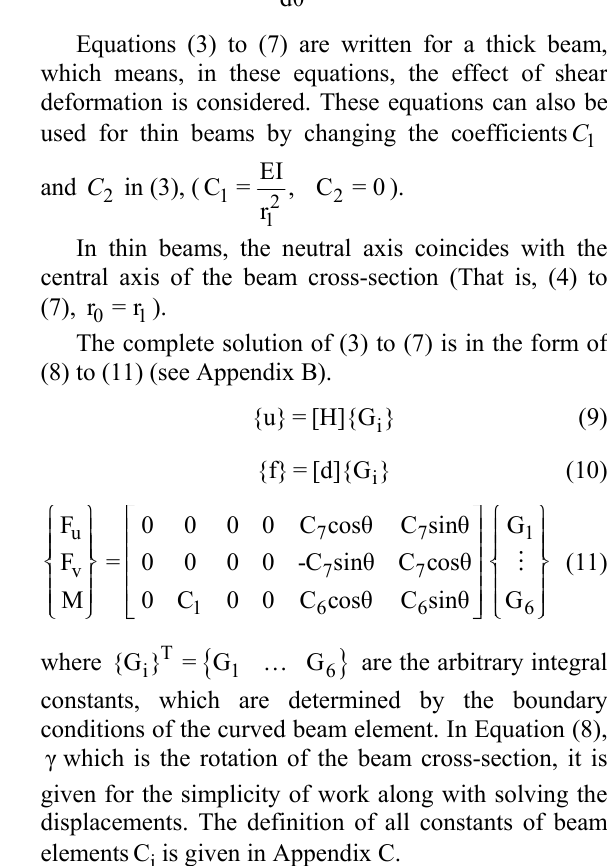
Figure 1. Forces and displacements in the curved beam element The stress-strain relationship in the tangential direction of the beam element is calculated by (4).